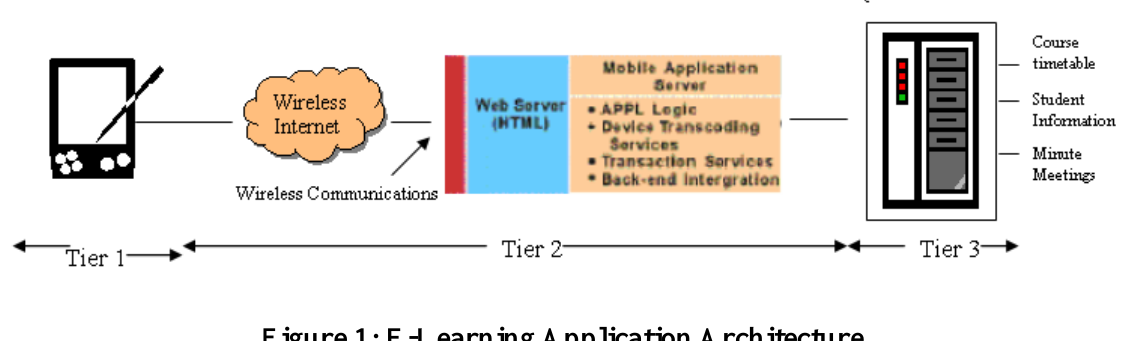
Figure 1: E-Learning Application